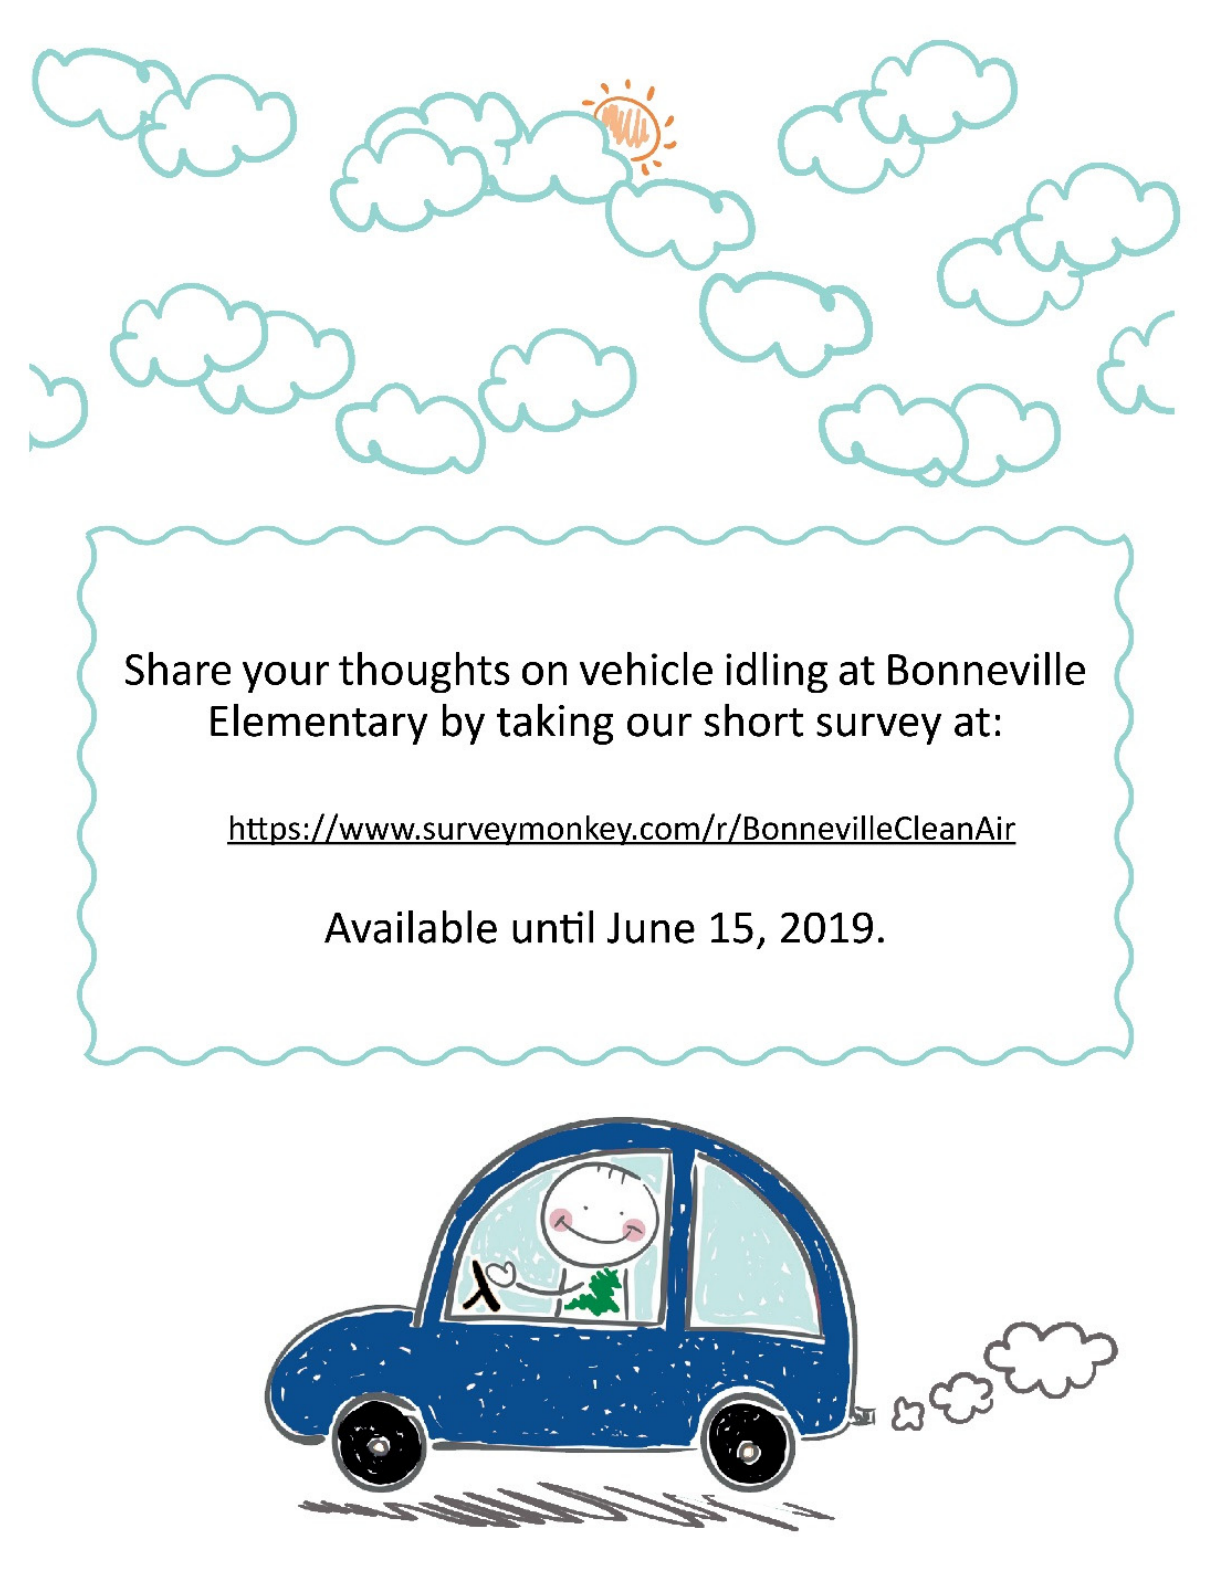
Figure A4. Clean air survey invitation flyer.